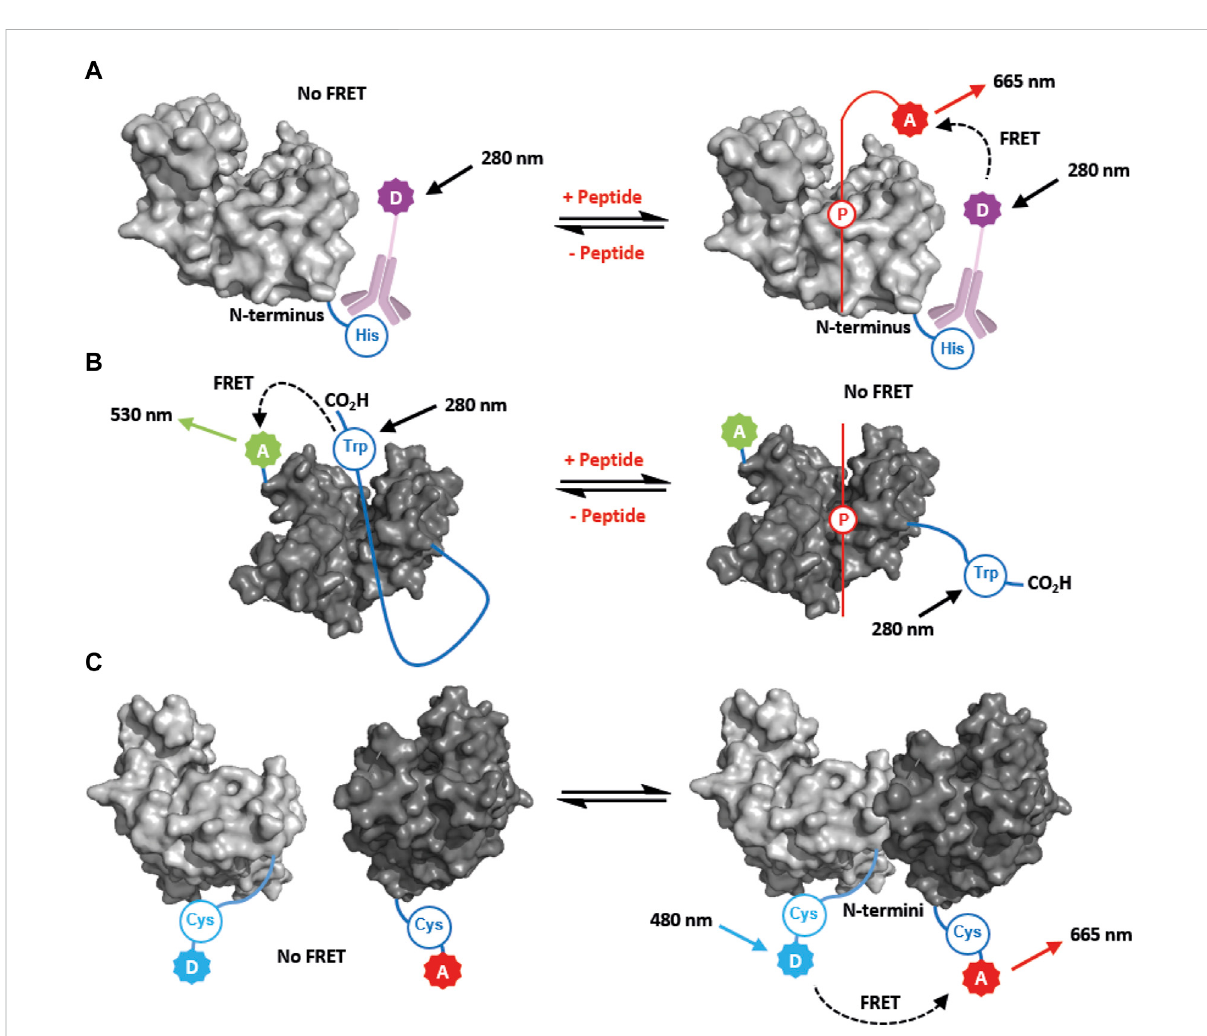
FIGURE 3 FRET-based approaches for studying 14-3-3 PPIs and structural dynamics. (A) FRET used to measure partner peptide binding. The partner peptide(red)islabelledwithaFRETacceptor,A.14-3-3islabelledwithaFRETdonor,D, via ananti-HisantibodythatbindstotheN-terminalHis-tag. (B) FRETusedtomeasure14-3-3 C-terminaldynamics.Atryptophanresidue(Trp)attheC-terminusisusedasaFRETdonor. ACysresidueproximal to the 14-3-3 binding groove is labelled with a FRET acceptor, A In the absence of a partner peptide the C-terminus of 14-3-3 occupies the groove, and FRET occurs. FRET is lost upon binding of a parner peptide (red) which displaces the C-terminal tail. (C) FRET used to monitor 14-3- 3 dimerisation. 14-3-3 monomers are differentially labelled with FRET donor, D, or acceptor, A, via the N-terminus. FRET occurs upon dimerisation when one 14-3-3 construct is titrated into the